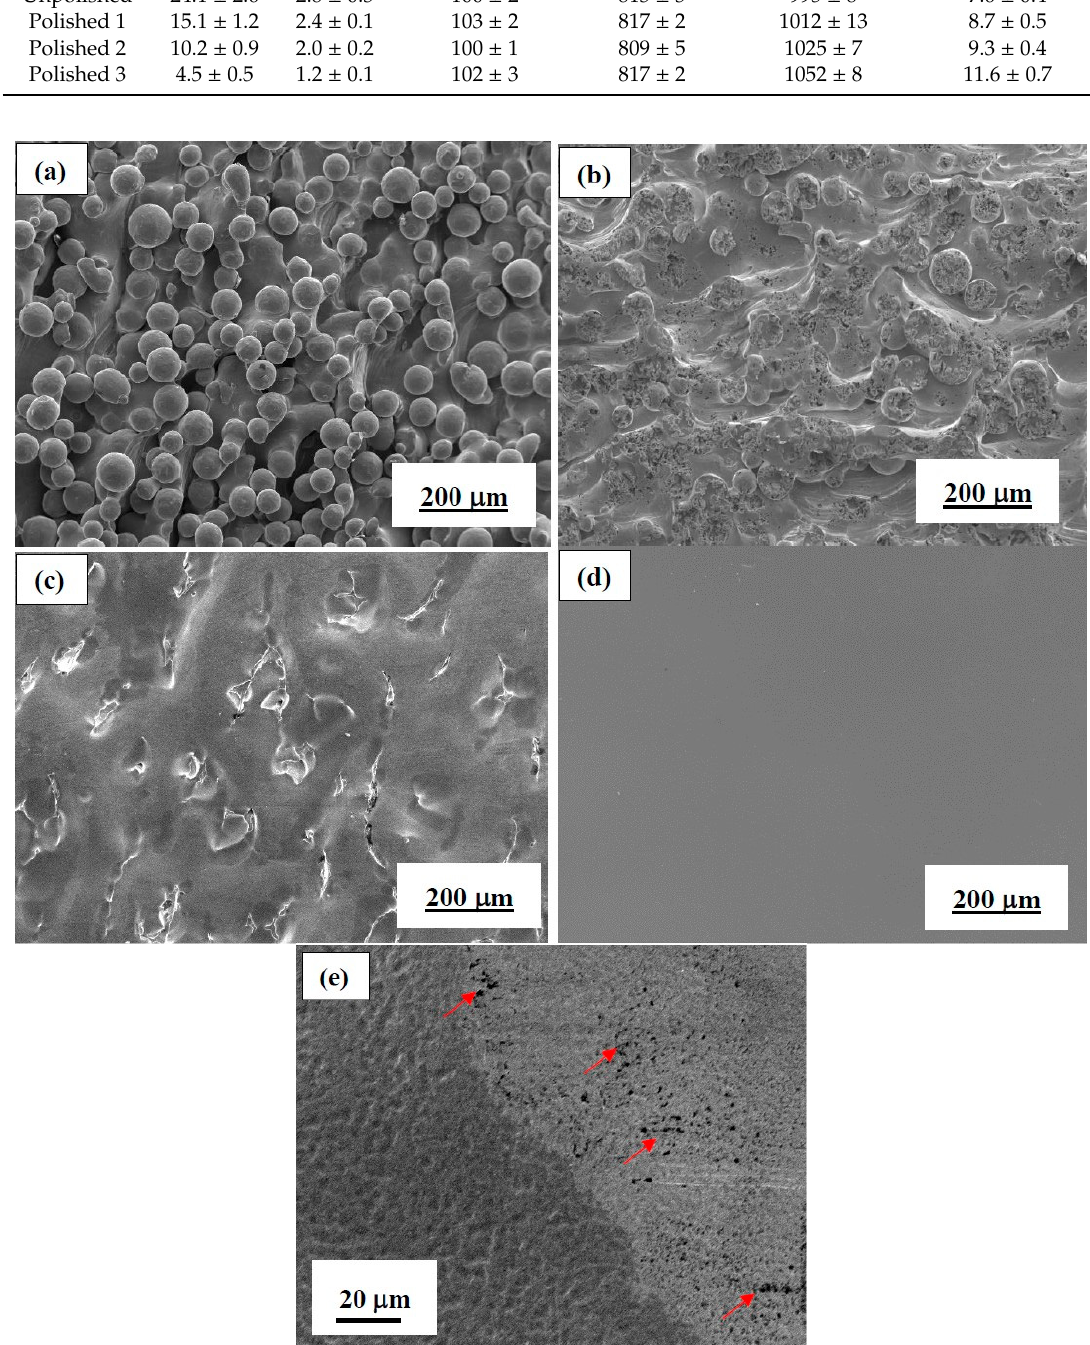
Figure 6. SEM micrographs of ( a ) the as-EBMed unpolished Ti6Al4V sample with Ra ~ 24 µm; and EPed samples with Ra about ( b ) 15 µm; ( c ) 10 µm; and ( d ) 4.5 µm; ( e ) Enlarged SEM micrograph showing the small black dots appeared after EP (likely over-electropolishing), and bio-corrosion pitting would be initiated from such dots, increasing the bio-corrosion current